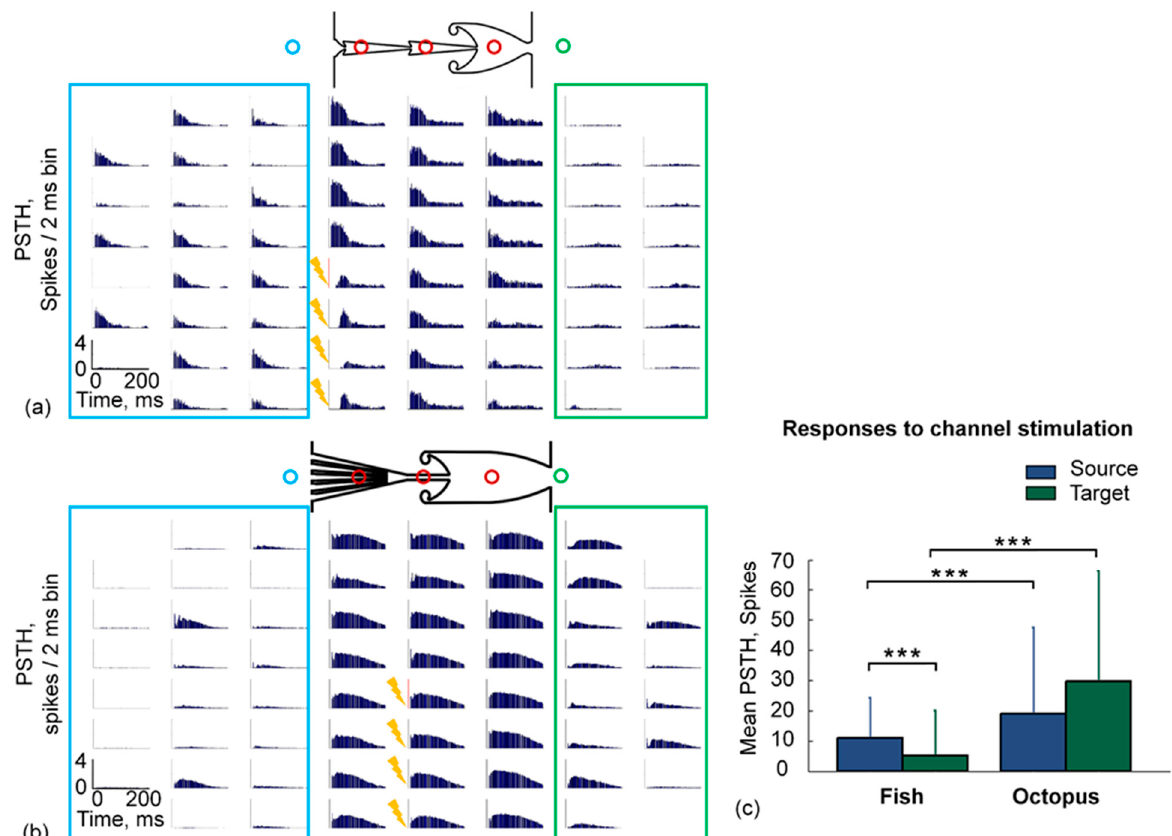
Figure 3. Spiking patterns in response to low-frequency test stimulation applied to the axons in the microchannels. PSTH map of the responses induced by test stimulation (see Methods) of four electrodes in microchannels in Fish ( a ) and Octopus ( b ) chip. ( c ) The mean PSTH of responses in the Source and the Target modules to electrical stimulation of four microchannels. Mann–Whitney Rank Sum Test, p < 0.001 (***).